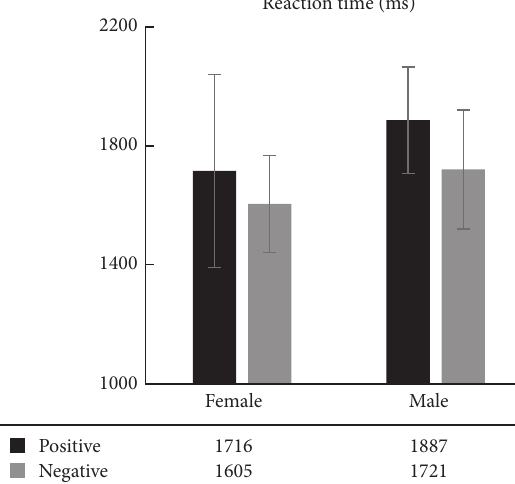
Figure 3: Comparison of pupil diameter changes between male and female patients with